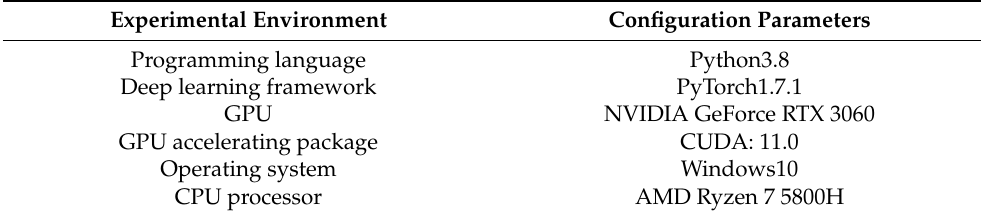
Table 1. Experimental environment